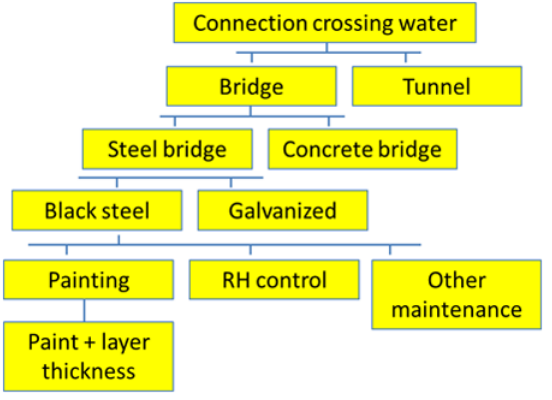
Figure 1 Connections across rivers and other watercourses can be made in several ways; the degree of specification detail increases gradually